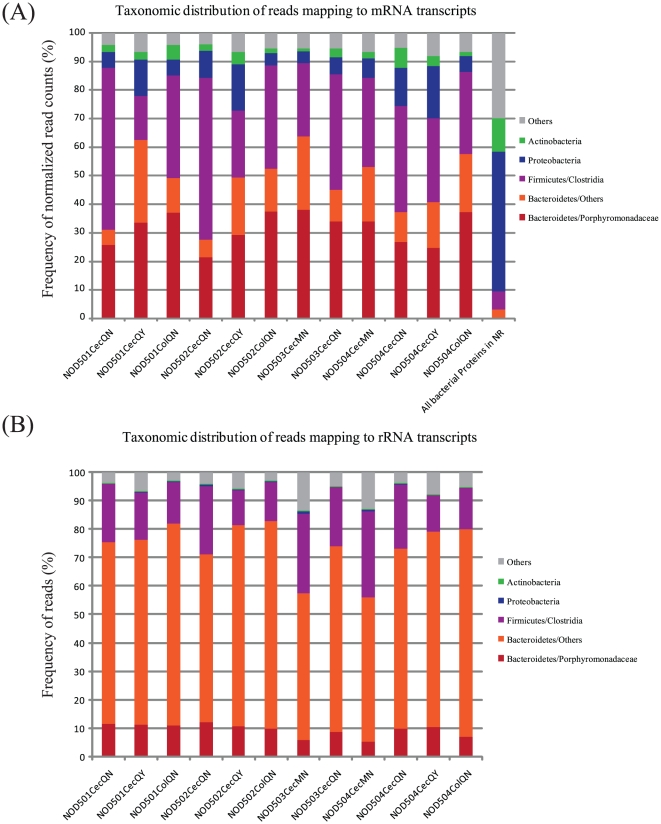
Phylogenetic distribution of transcripts mapped to known bacterial genes.(A) Distribution of mRNA transcripts. (B) Distribution of rRNA transcripts. Results are shown for the 12 independent samples described in Table 1. Consistent with 16S rRNA studies, the vast majority of identified mRNA transcripts derive from Parabacteroides, Bacteroides or Clostridial species.